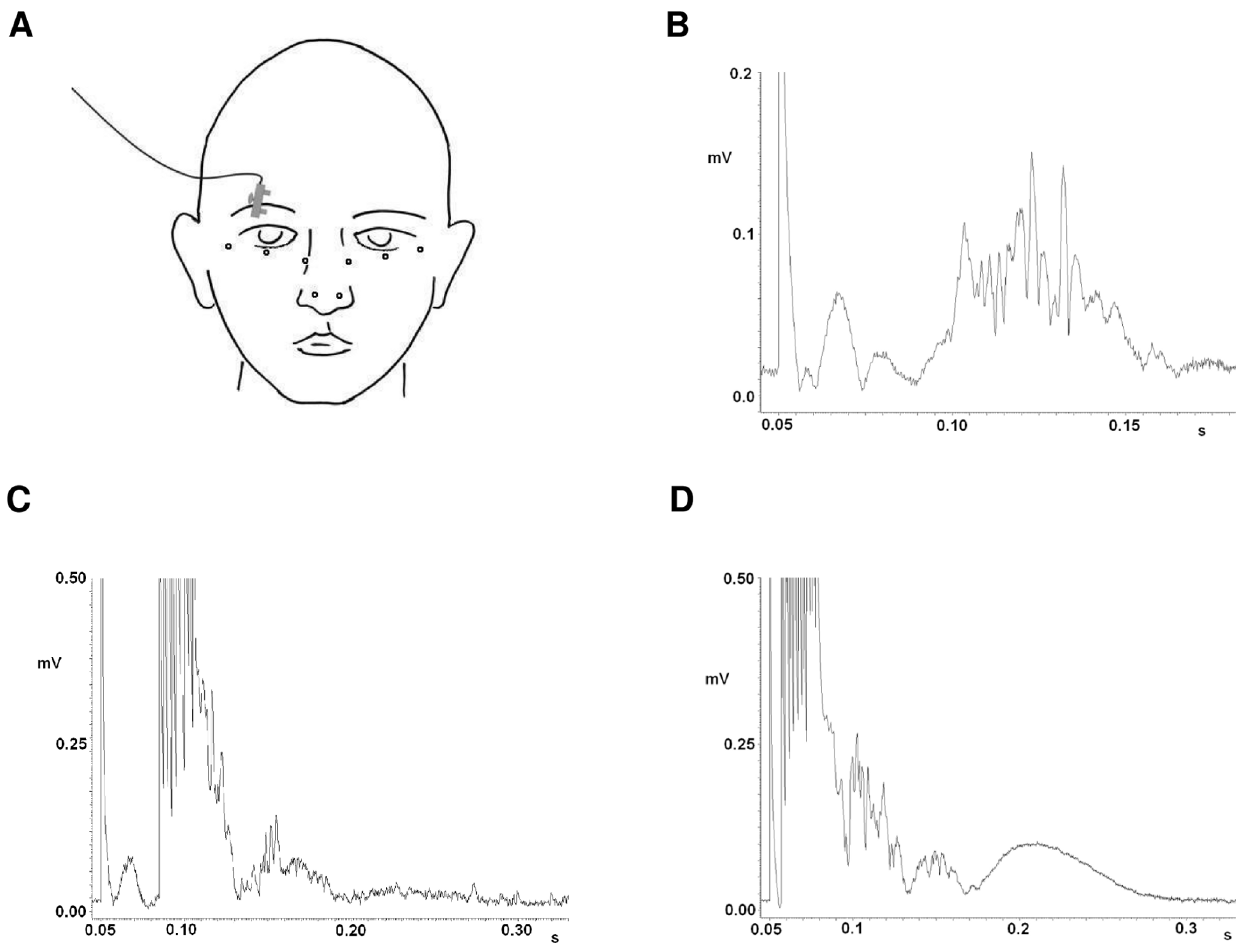
Figure 3. Electrode placement and examples of the R2 response. Panel A: Placement of the electrodes around the orbicularis oculi and nasalis muscles. The right supraorbital nerve was stimulated. Panel B: Example of ipsilateral R1 and R2 responses after single pulse stimulation. Panel C: Example of HFS LTP protocol. High frequency stimulation was given at the onset of the R2 response to induce LTP-like effects. Panel D: Example of HFS LTD protocol. Here, HFS was applied before the onset of the R2 response to induce LTD-like effects.